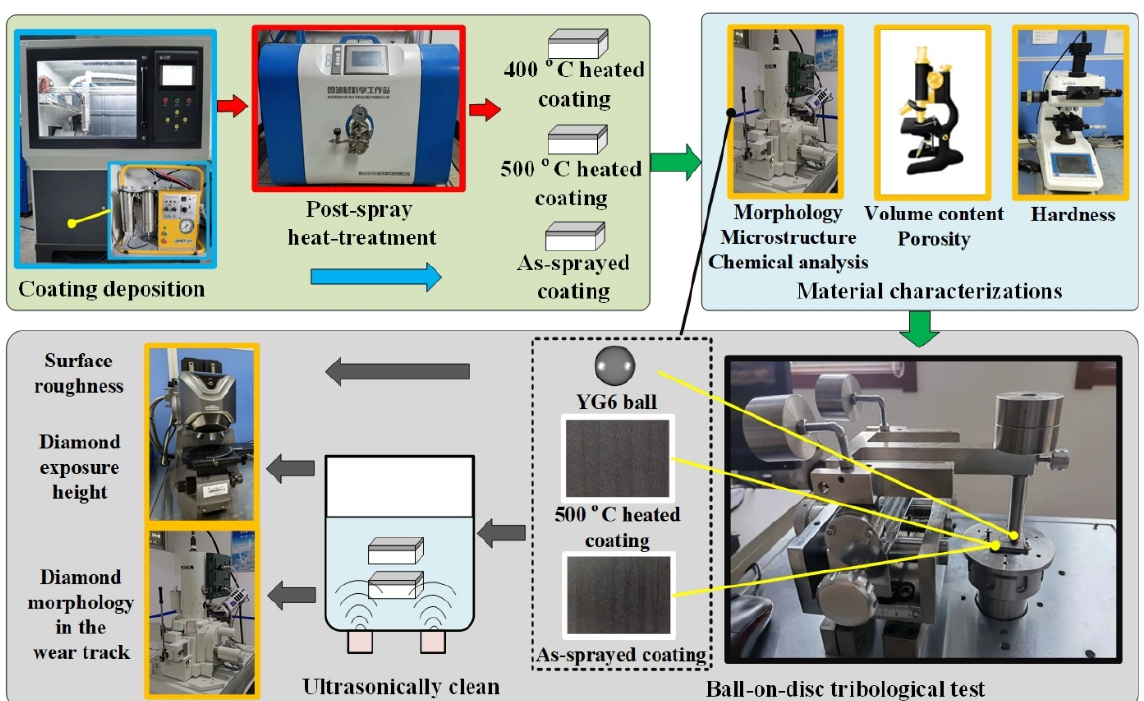
Figure 3. Experimental procedures and measurement schemes of fabricating and testing porous metal-bonded diamond coatings (heated coatings).